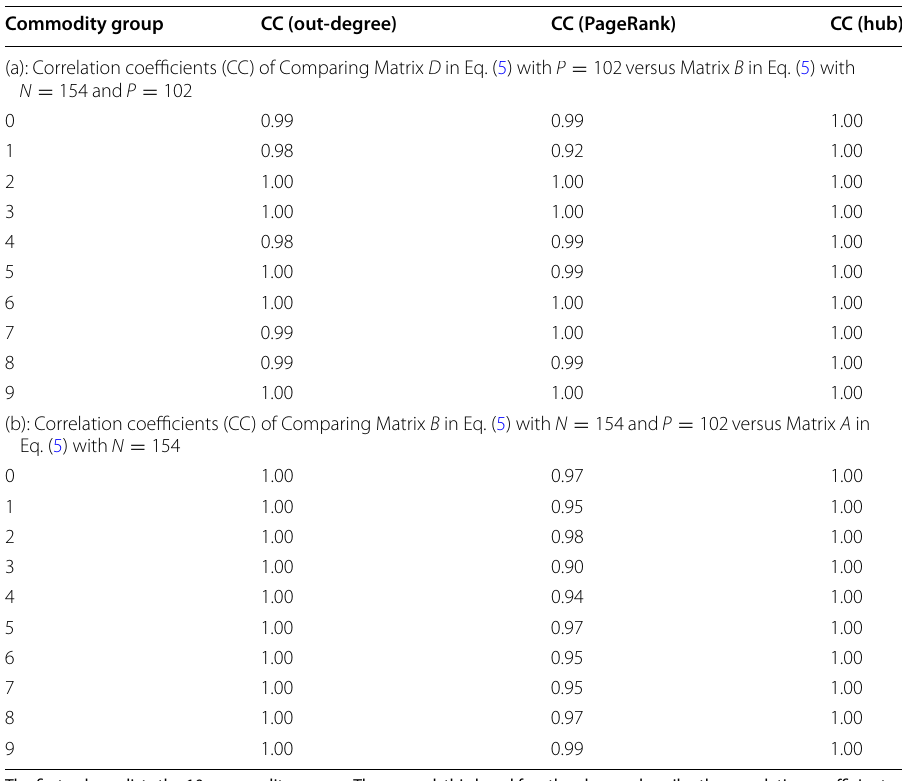
Table 5 Correlation coefficients between the rank of 154 countries in full 154-country network and reduced 154-country network [part (a)], and correlation coefficients between the rank of 102 countries in reduced 154-country network and the 102-country network [part (b)] based on centrality measures in export sector